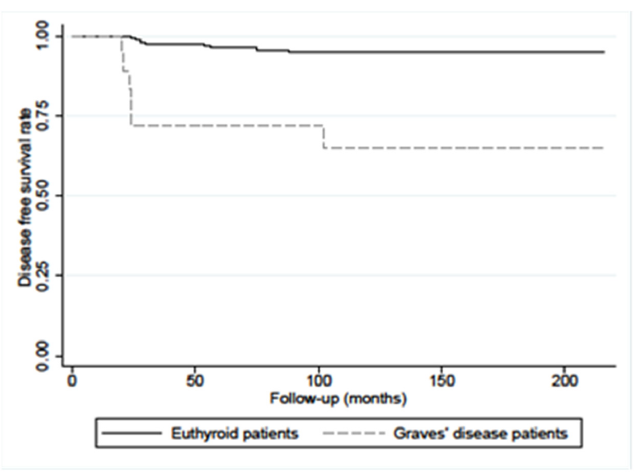
Figure 4. Disease-free survival (DFS) in PC/GD patients (n.18) and in matched euthyroid PC control patients (n.164) with microcarcinoma ( ≤ 1 cm) showed a statistical difference ( p < 0.0001, calculated with log-rank test).